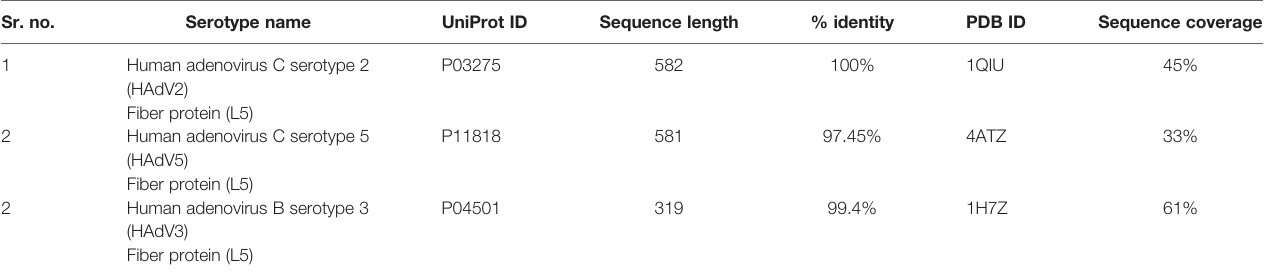
TABLE 2 | Adenovirus serotypes L5 protein. Sr.